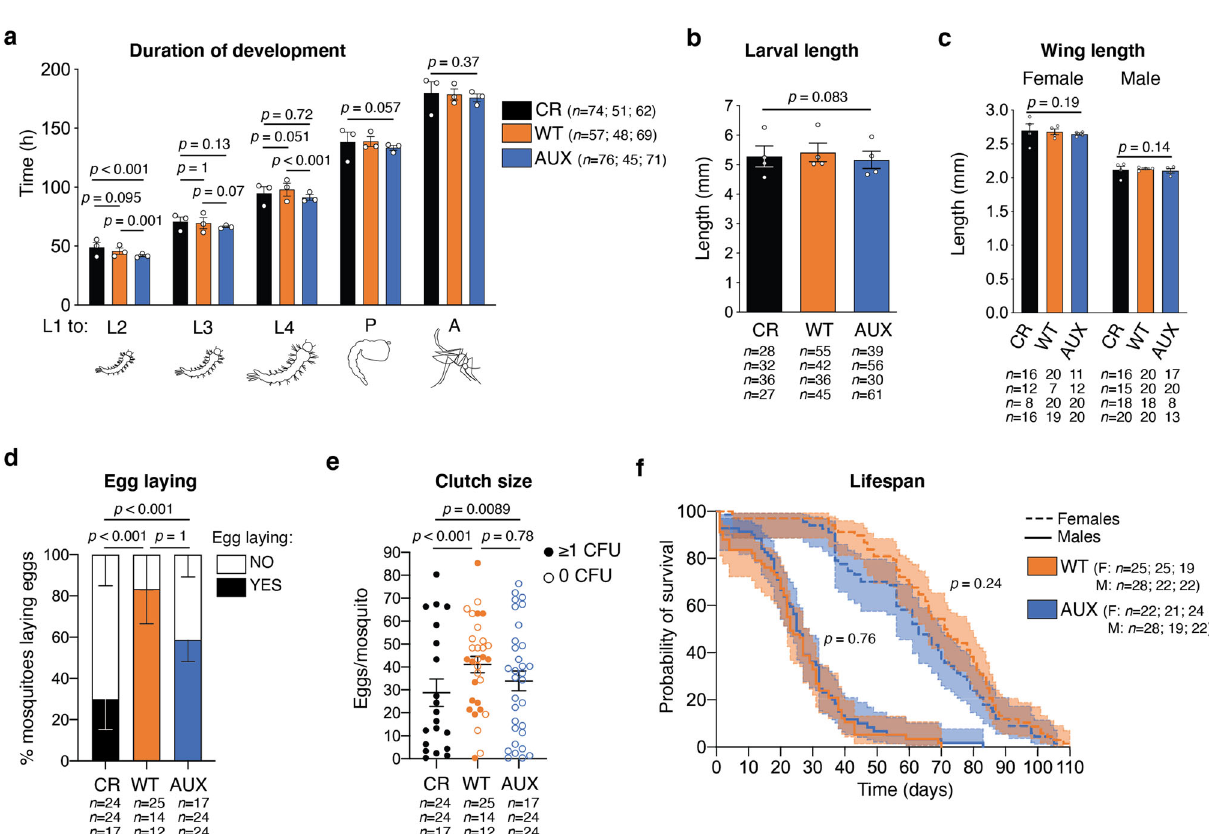
Table S1 for detailed statistical information. Source Data are provided as a Source Data fi